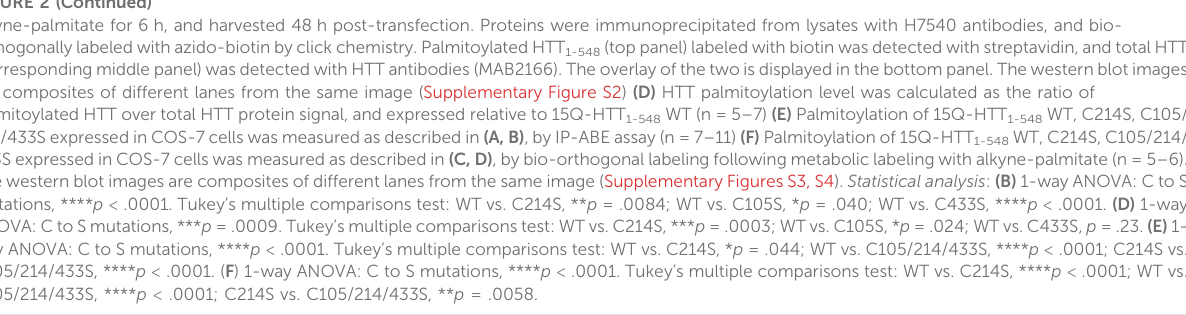
HTT 1-1212 WT, or carrying two cysteine-to-serine mutations at C1027 and C1028 (C1027/1028S) was measured in COS-7 cells using the IP-ABE assay (Figure 3A). The palmitoylation level of 15Q-HTT C1027/1028S was not signi fi cantly modi fi ed compared to the WT control (Figure 3B; t -test: p = .11). The dynamic palmitoylation level of 15Q- HTT 1-1212 WT or C1027/1028S was also measured in COS-7 cells by bio- orthogonal labeling assay following metabolic labeling with alkyne- palmitate (Figure 3C). The palmitoylation level of 15Q-HTT C1027/ 1028S was signi fi cantly increased compared to the WT control (Figure 3D; t -test: p = .0058). The higher palmitoylation turnover measured with the bio-orthogonal labeling assay, without any change of the total palmitoylation level with the ABE assay, could be explained by an increased palmitoylation dynamism at other HTT residues